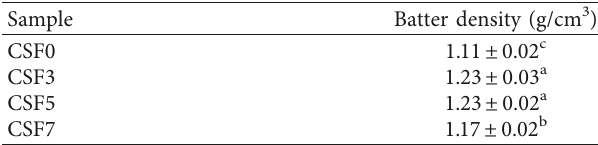
Table 3: Effect of replacing egg by chia seed flour (CSF) on batter